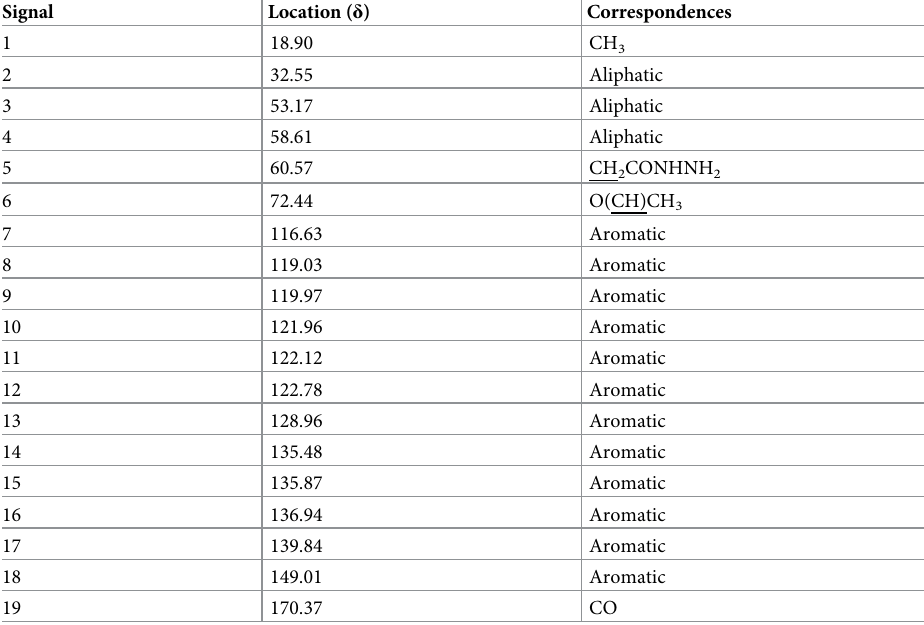
Table 2. 13 C-NMR spectral data of acetohydrazide derivative of CZT.